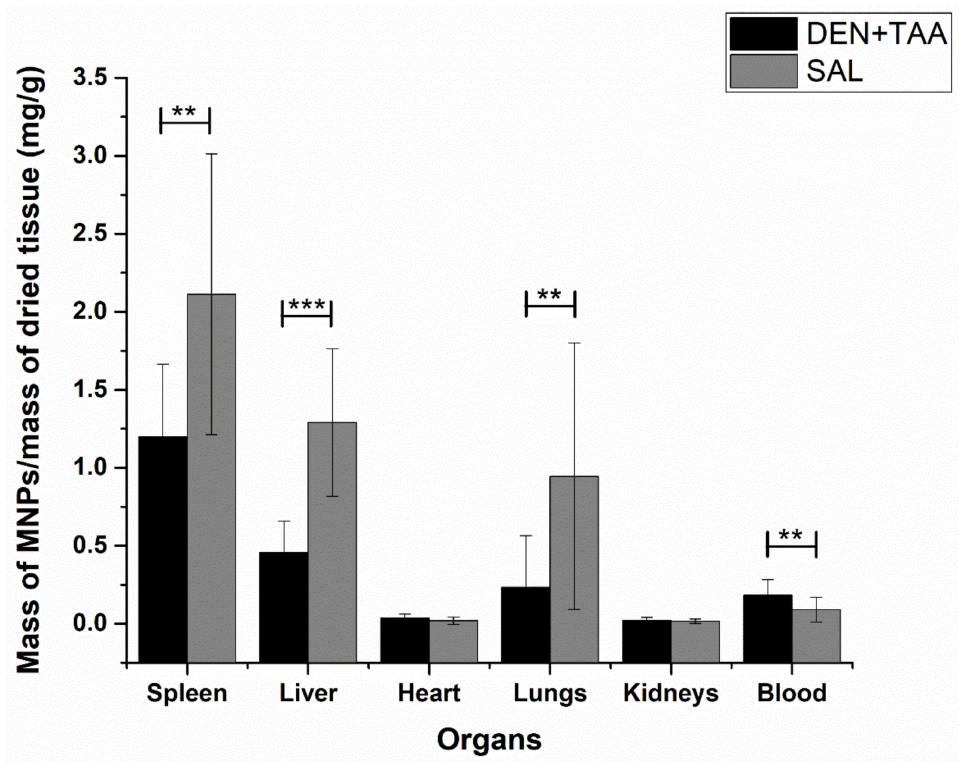
Figure 5. ACB data for MNP biodistribution in SAL and DEN/TAA; ** p < 0.05; *** p <